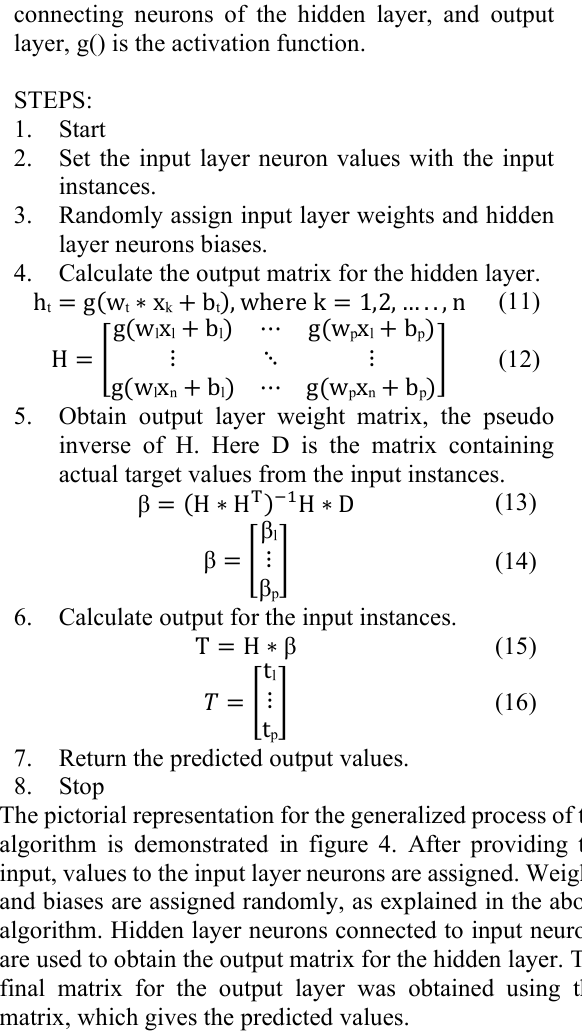
Algorithm: Extreme Learning Machine